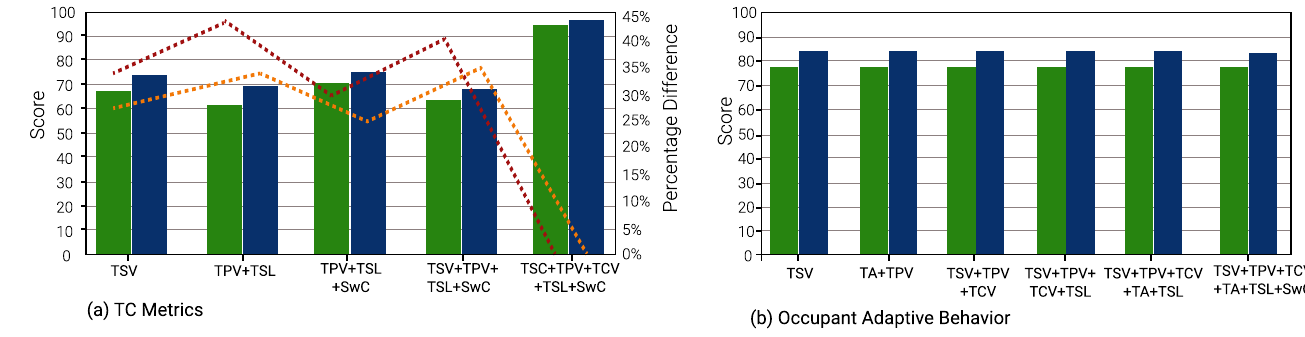
Figure 10. Gradient Boost Algorithm for Winter Survey.